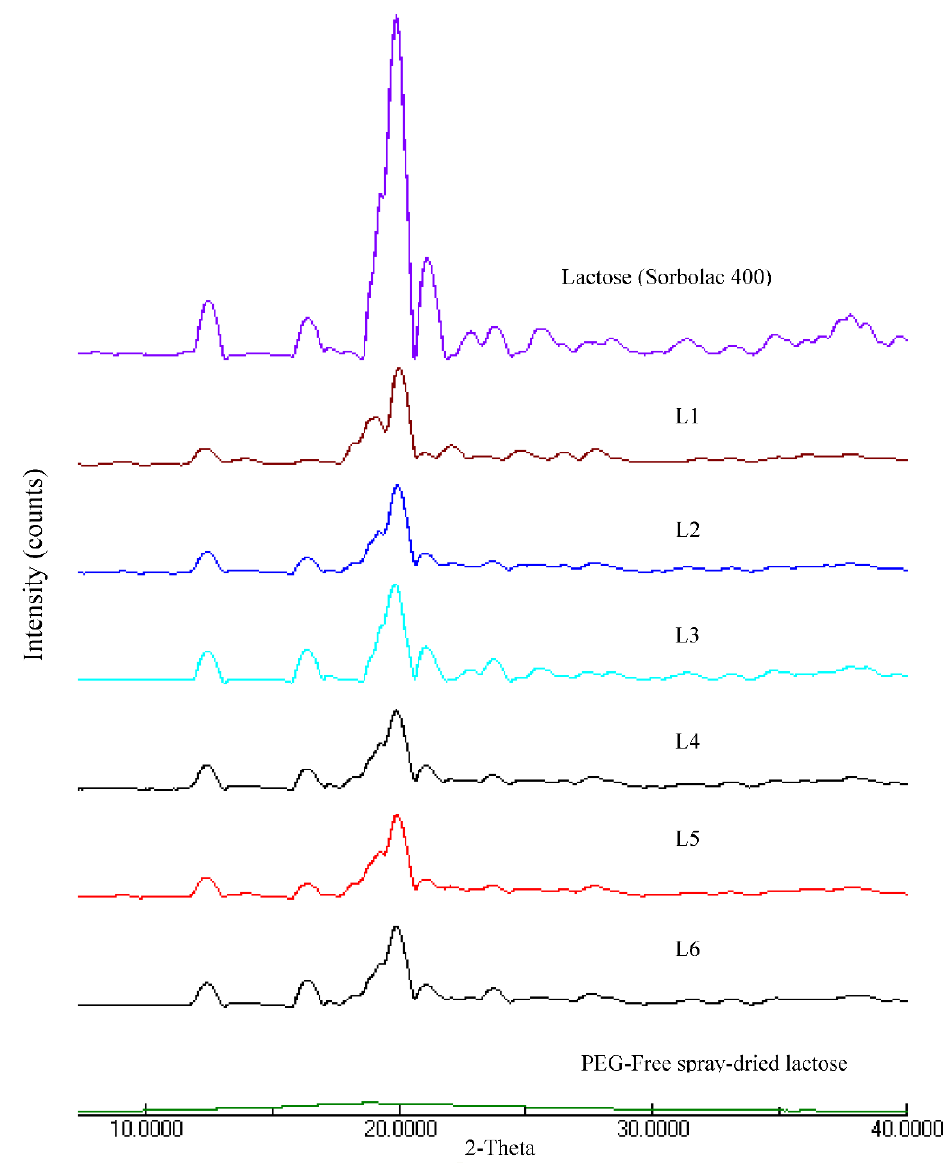
Figure 2. X-ray powder diffractograms of lactose and lactose-PEG microparticles.